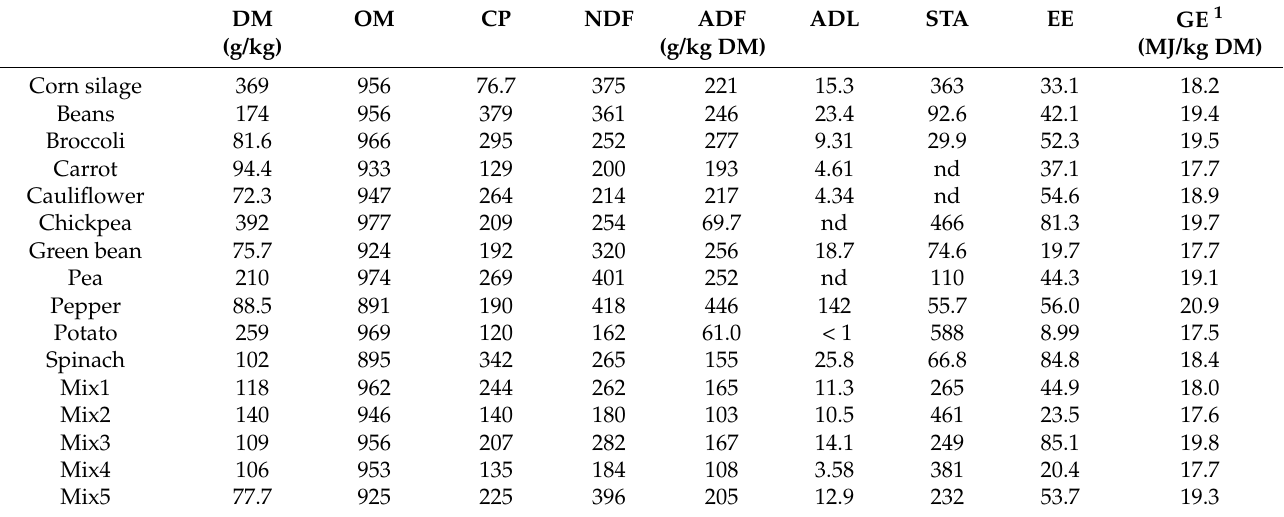
Table 3. Chemical composition (g/kg DM) and gross energy (MJ/kg DM) of corn silage and vegetable